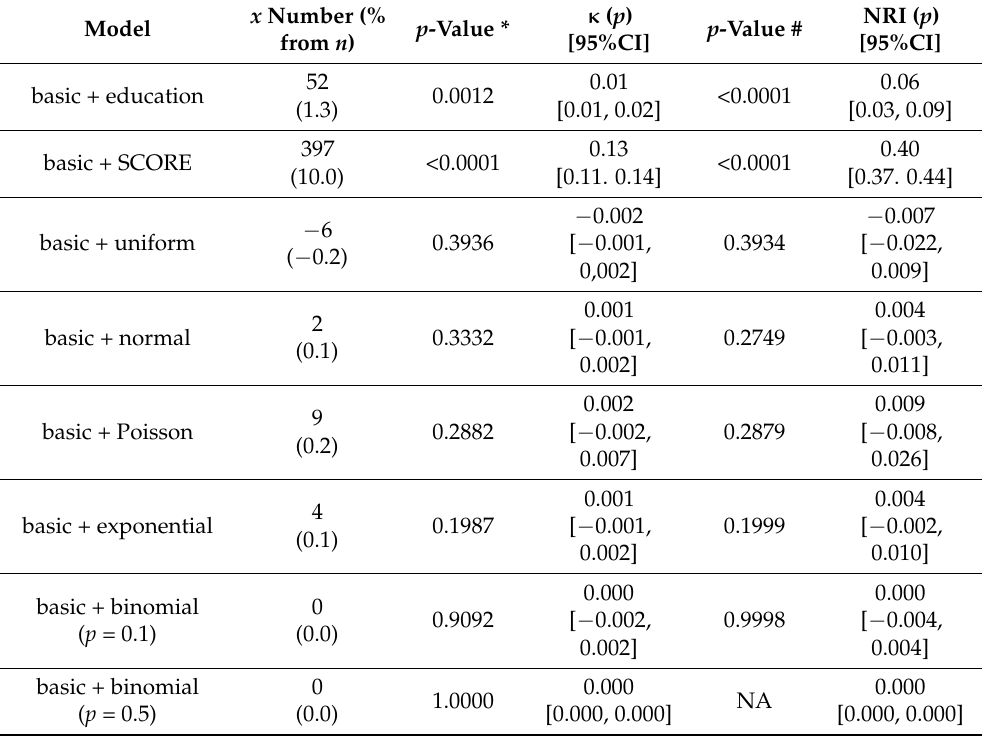
Table 8. Reclassification quality based on Cohen Kappa and Net Reclassification Improvement (NRI) for a categorial risk of the CVD (between the base and extended logistic regression models). The two risk categories were built based on a cut-off value p = 0.4444. κ ( p ) x Number (% NRI ( p ) p -Value # p -Value * Model [95%CI] [95%CI] from n ) 0.06 0.01 52 <0.0001 0.0012 basic + education [0.03, 0.09] [0.01, 0.02] (1.3) 397 <0.0001 basic + SCORE (10.0) basic + uniform ( − 0.2)